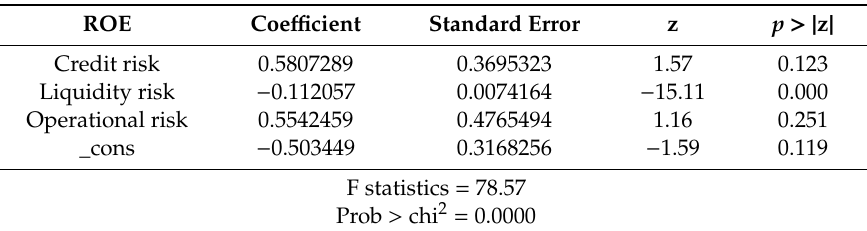
Table 5. Regression results with return on equity